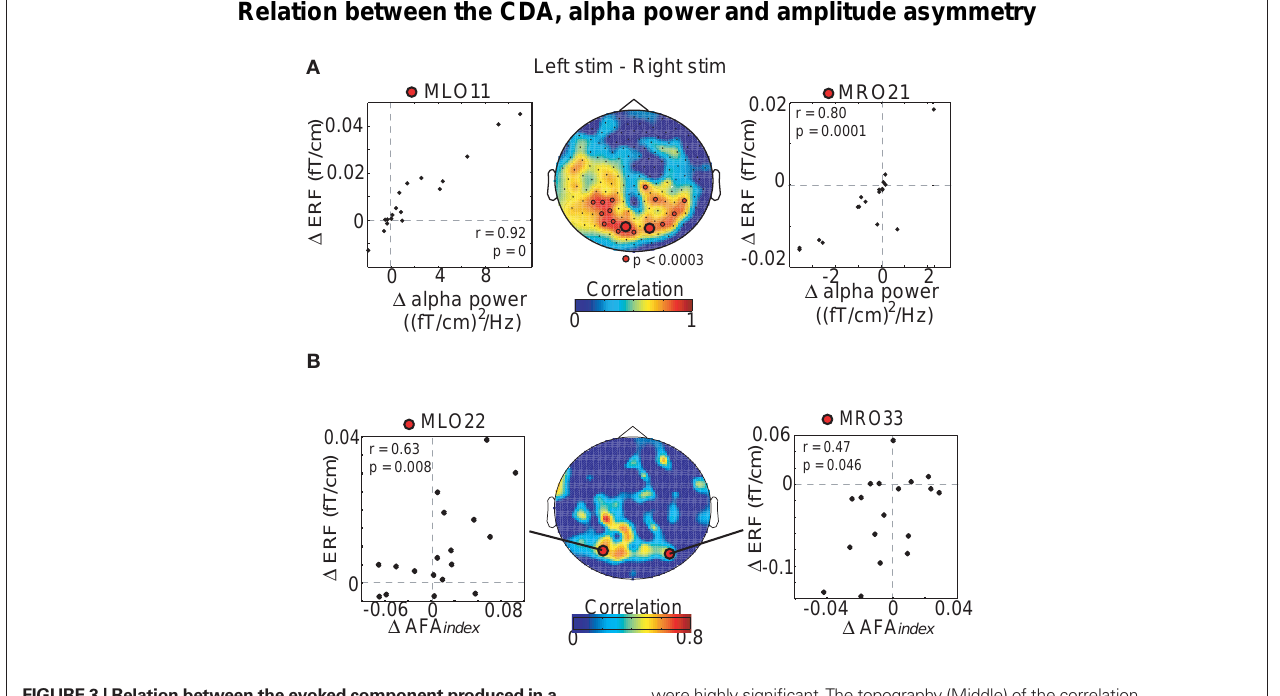
Figure 3 | relation between the evoked component produced in a working memory task and modulations in hemispheric alpha power lateralization. (A) Correlation over subjects of differences in ERFs and alpha power modulations [left minus right target stimuli (stim)] for a left sensor and a right sensor (Left and Right, respectively). The correlations